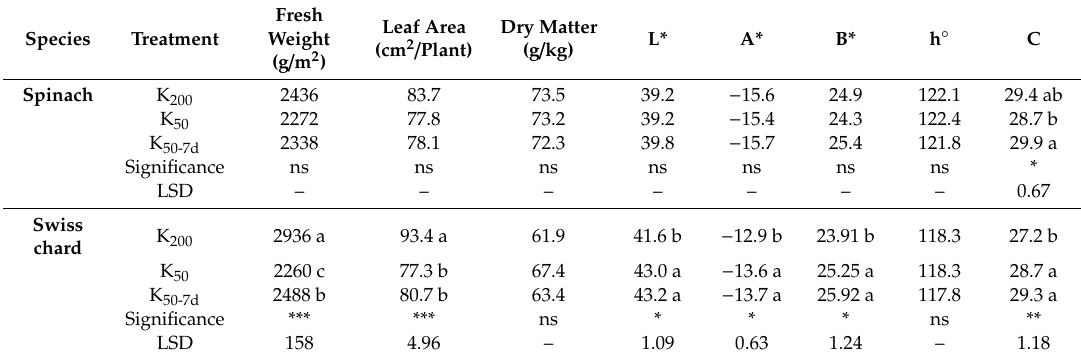
Table 2. E ff ects of potassium (K) concentration in nutrient solution (NS) and duration of K restriction on yield (shoot fresh weight), leaf area, dry matter, and color parameters (L*, a*, b*, h ◦ , C) of hydroponic spinach and Swiss